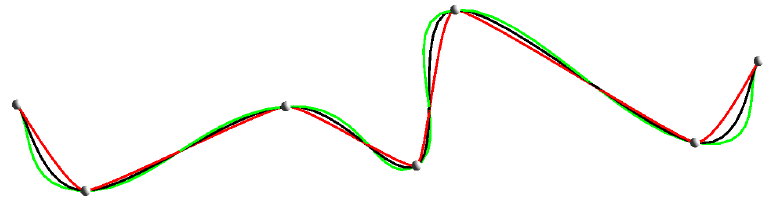
Figure 9. Change of curve according to τ : red 0.2, black 0.5, green 0.75 [21].